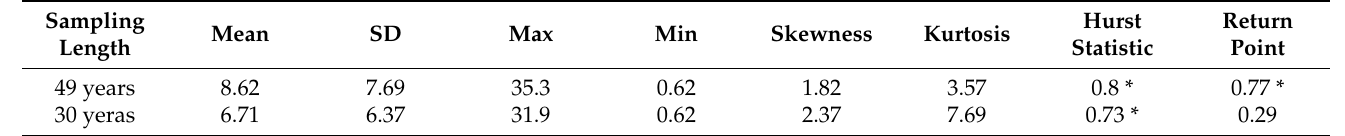
Table 1. Statistical characteristics (in m 3 /s) of case study (Mean: average; SD: Standard Deviation; Max: Maximum; Min: